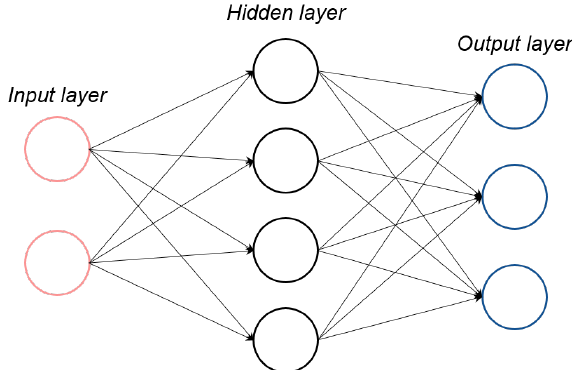
Figure 9. The scheme of an ANN, which normally consists of an input layer, hidden layer and output